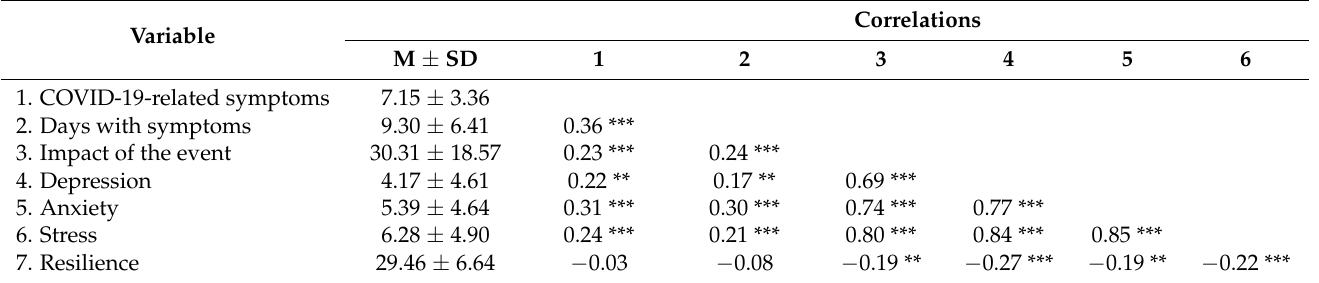
Table 2. Median, standard deviation, and correlations between the variables of